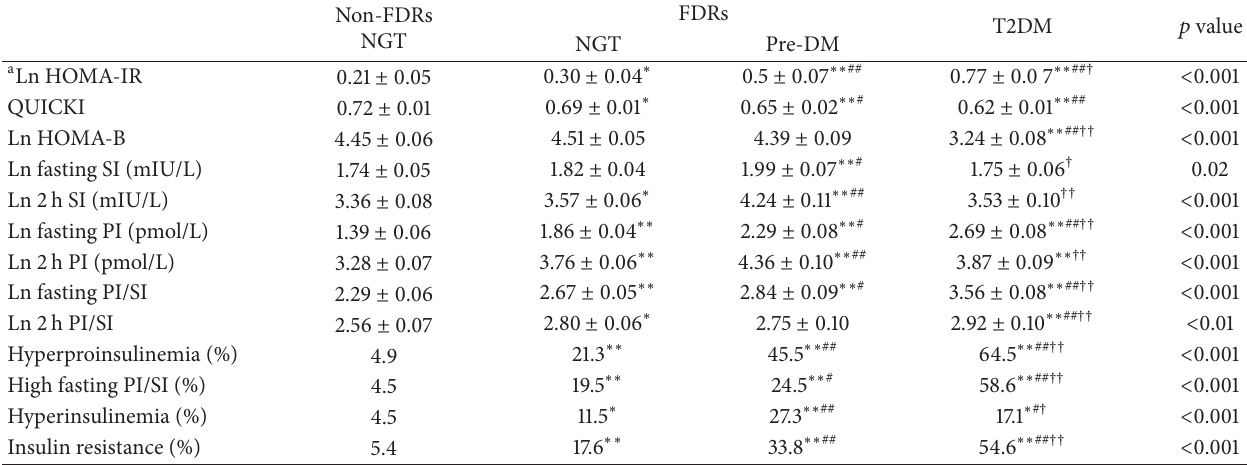
Table 2: Comparisons of insulin resistance and 𝛽 -cell function in different groups.